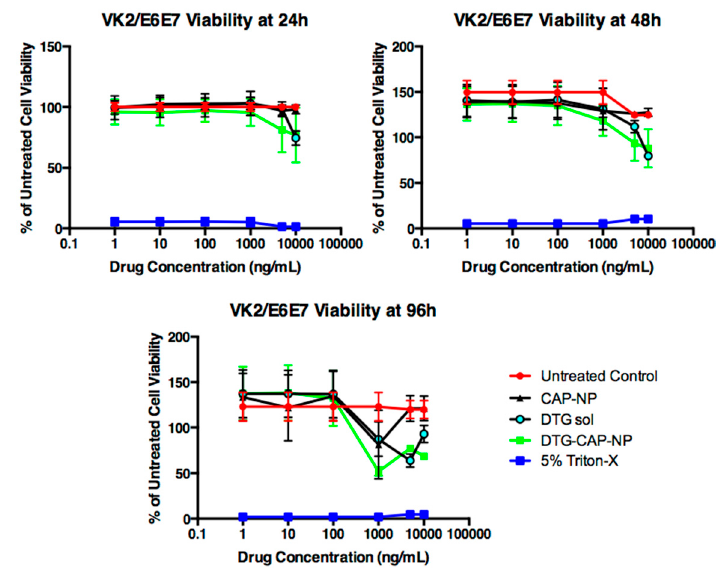
Figure 5. Vaginal epithelial VK2/E6E7 cell viability following treatment with DTG sol, CAP–NPs, and DTG–CAP–NPs at pH 7.4 ( n = 6). Untreated control cells were used to indicate normal cell growth for three days in culture. Five-percent Triton-X treatment was used as a cytotoxicity control. Error bars represent SD.